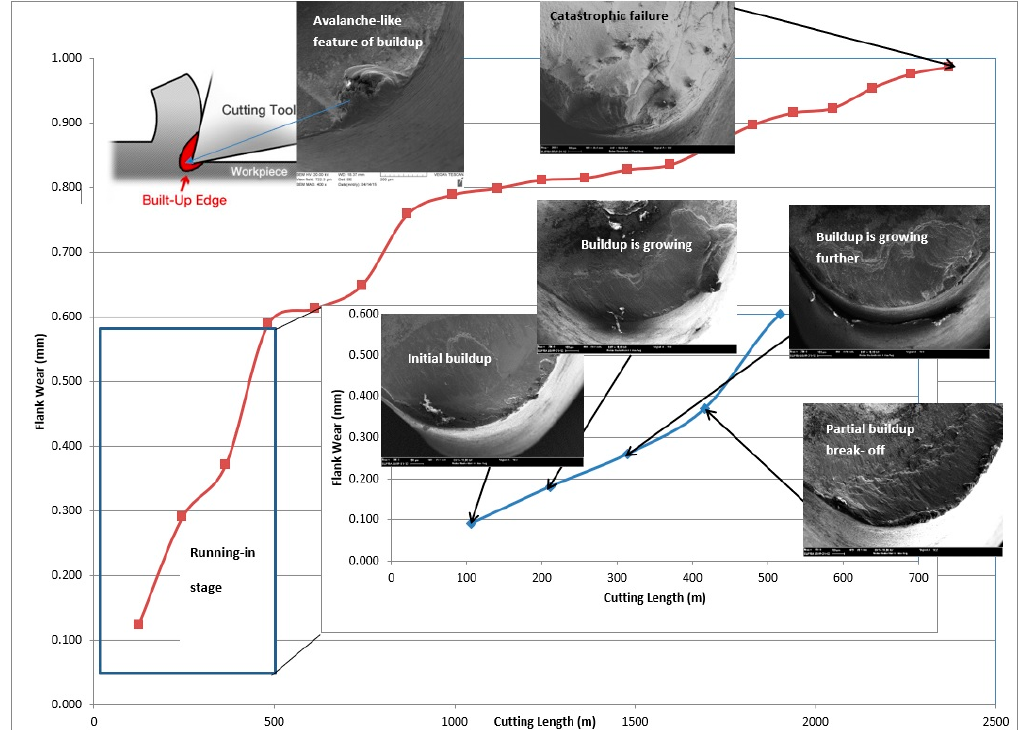
Figure 1. Schematic presentation of super duplex stainless steel (SDSS) machining with built-up edge formation using an uncoated cemented carbide cutting tool. Wear resistance data with progressive Scanning Electron Microscope (SEM) studies of built-up edge formation on the friction surface. Reproduced from [31].